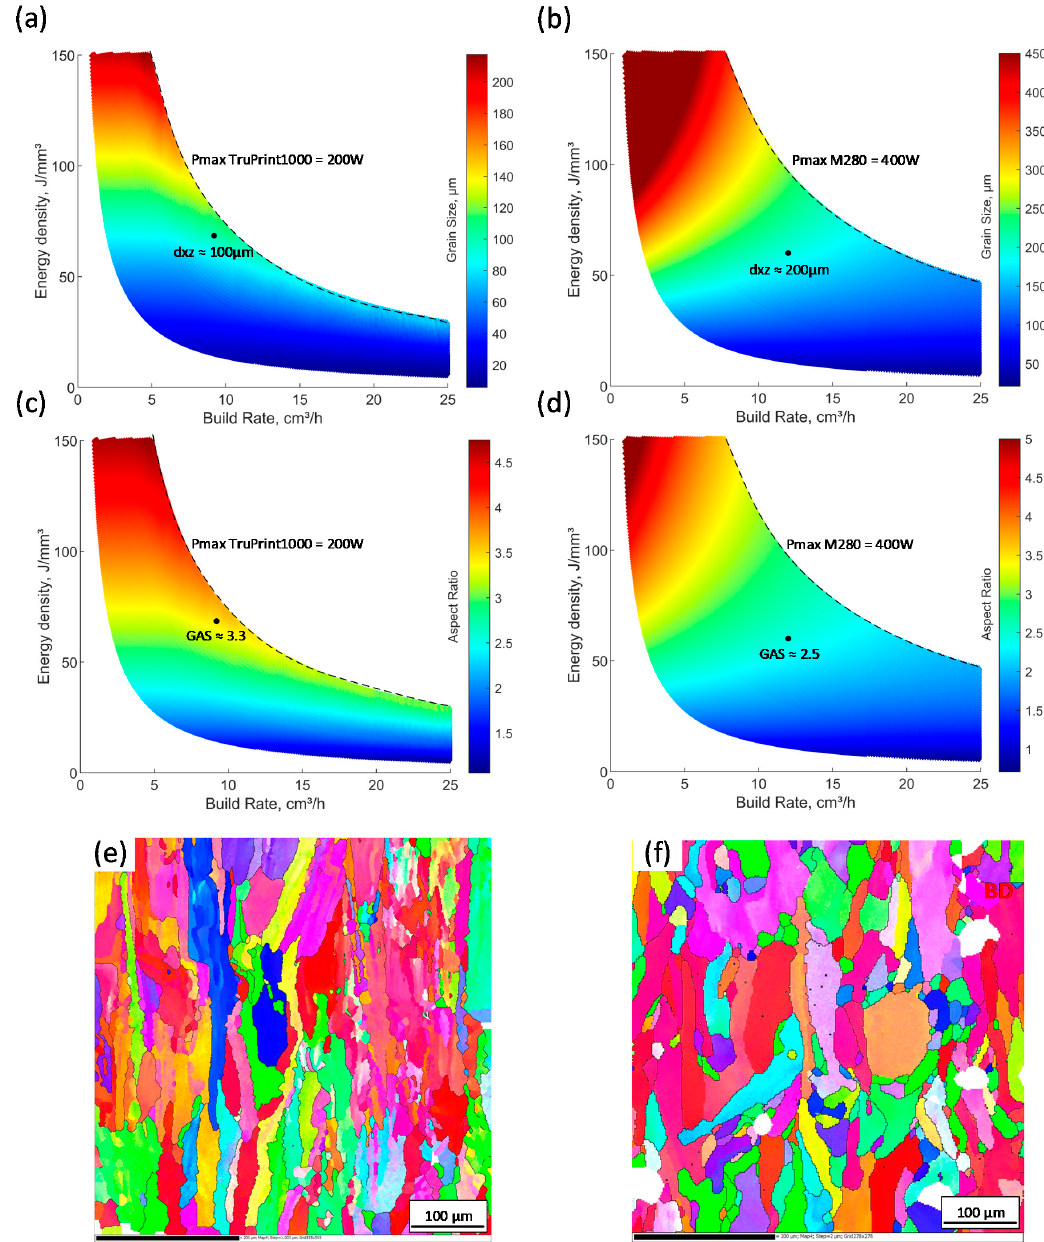
Figure 8. Microstructure and inverse pole figures of the Ti-Zr-Nb alloy printed using different LPBF systems: ( a , c , e ) TruPrint 1000 (Trumpf) and ( b , d , f ) M280 (EOS). systems: ( a , c , e ) TruPrint 1000 (Trumpf) and ( b , d , f ) M280